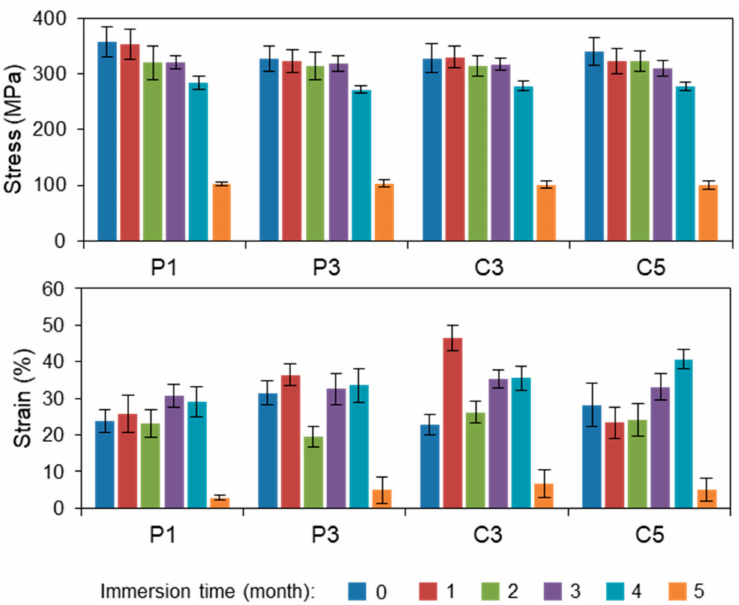
Figure 10. Tensile properties of the degraded